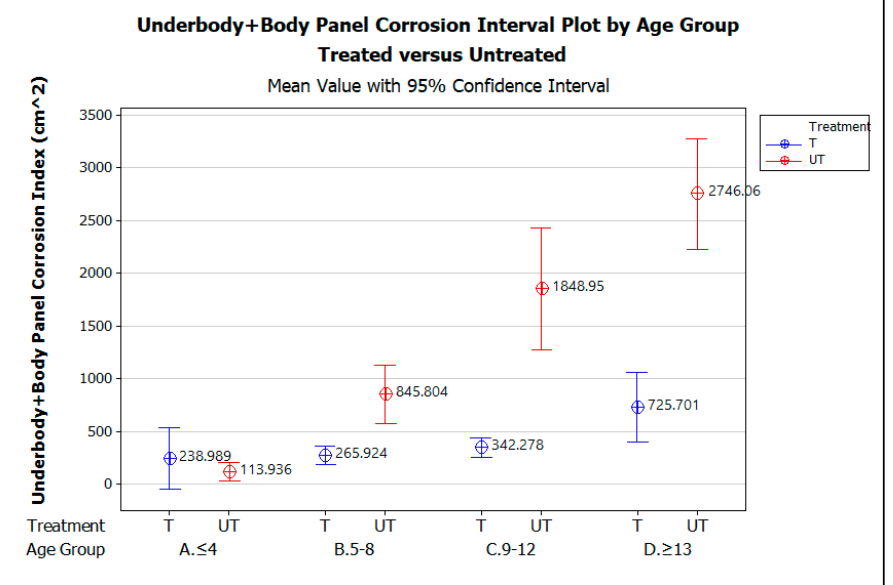
Figure 7. Underbody + Body Panel corrosion interval plot by vehicle age group, A. ≤ 4 yrs, B. 5–8 yrs, C. 9–12 yrs, and D. ≥ 13 yrs, comparing treated versus untreated vehicles. The graph demonstrates that for vehicles up to 4 years of age, there is no statistically significant difference in the amount of corrosion measured on the treated versus untreated vehicles, as indicated by the way the error bars for the treated vehicles overlap those for the untreated vehicle. The lack of a statistically significant difference in measured corro- sion on the treated and untreated vehicles within this age group is likely due to the effec- tiveness of the OEM corrosion prevention measures applied when these early model ve- hicles were manufactured. From the ages of 5 to 13 years and beyond, however, the graphs show that, statistically, significantly less corrosion was measured on the treated vehicles than the untreated vehicles. Although the amount of corrosion increases with vehicle age for both the treated and untreated vehicles, the increase in corrosion with increasing ve- hicle age is greater on average for the untreated vehicles than for the treated. 4. Discussion By using analysis of variance (ANOVA), the preliminary statistical analyses of the Corrosion Index (CI) values for the Body Panels, the Underbody parts, and the Under- body+Body Panels for treated and untreated vehicles identified statistically significant correlations between Corrosion Index and treatment (treated versus untreated) as well as between Corrosion index, vehicle age group, and treatment. The ANOVA results demon- strate that the corrosion measurements made using the digital image analysis methodol- ogy are statistically significant. Less corrosion was measured on the treated corrosion- prone vehicle parts than on the untreated corrosion-prone vehicle parts, confirming that the digital image analysis process applied in this research is a viable method of measuring corrosion on vehicles. The ability to measure and track the effectiveness of corrosion pre- vention is critical given the increasing life of active vehicles and the consequences of pre- ventable corrosion. The results presented are directly applicable to assessing actual vehi- cle components that corrode in the environment.